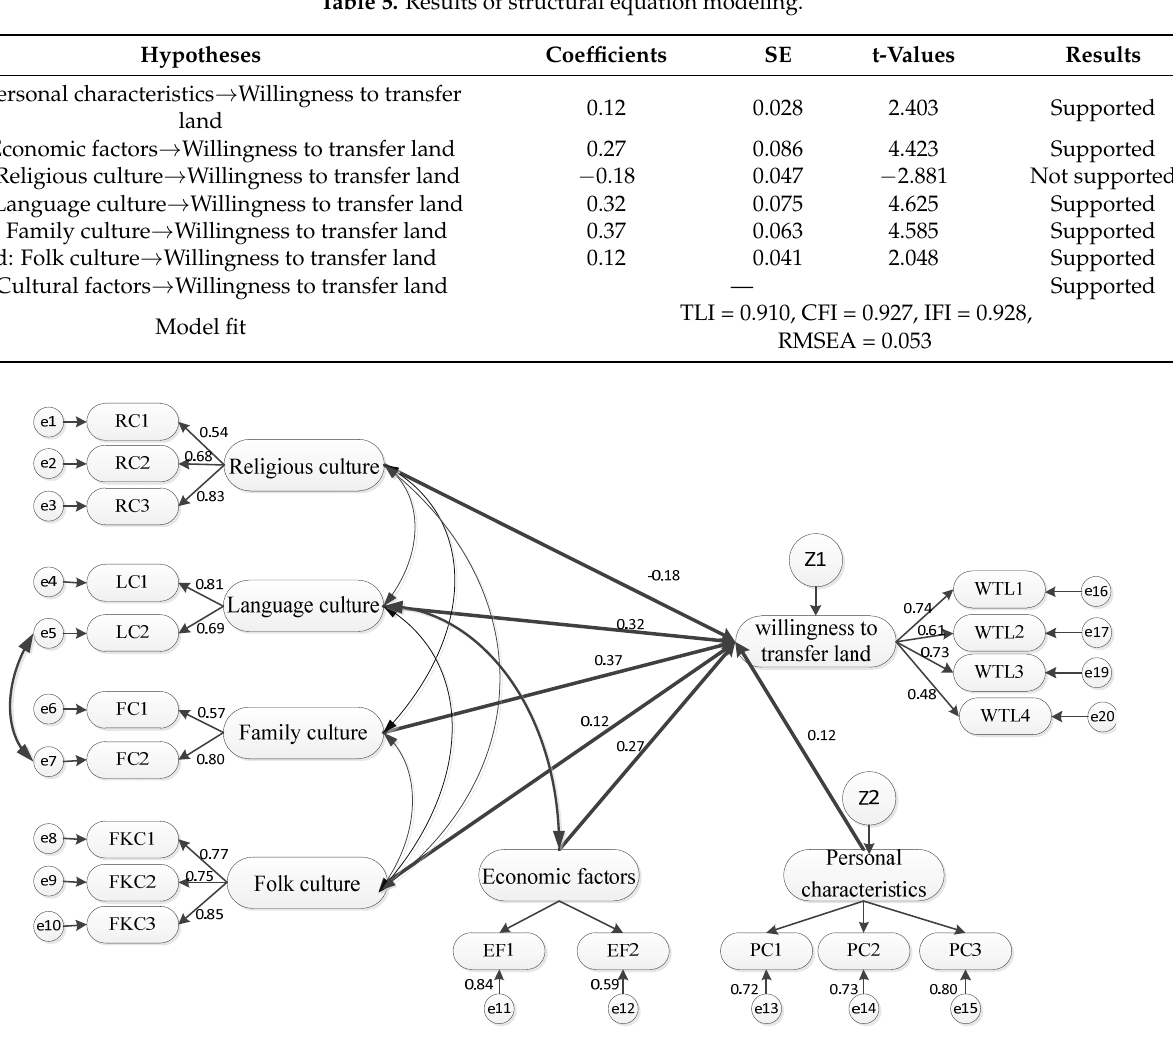
Figure 3. Results of structural equation modeling.